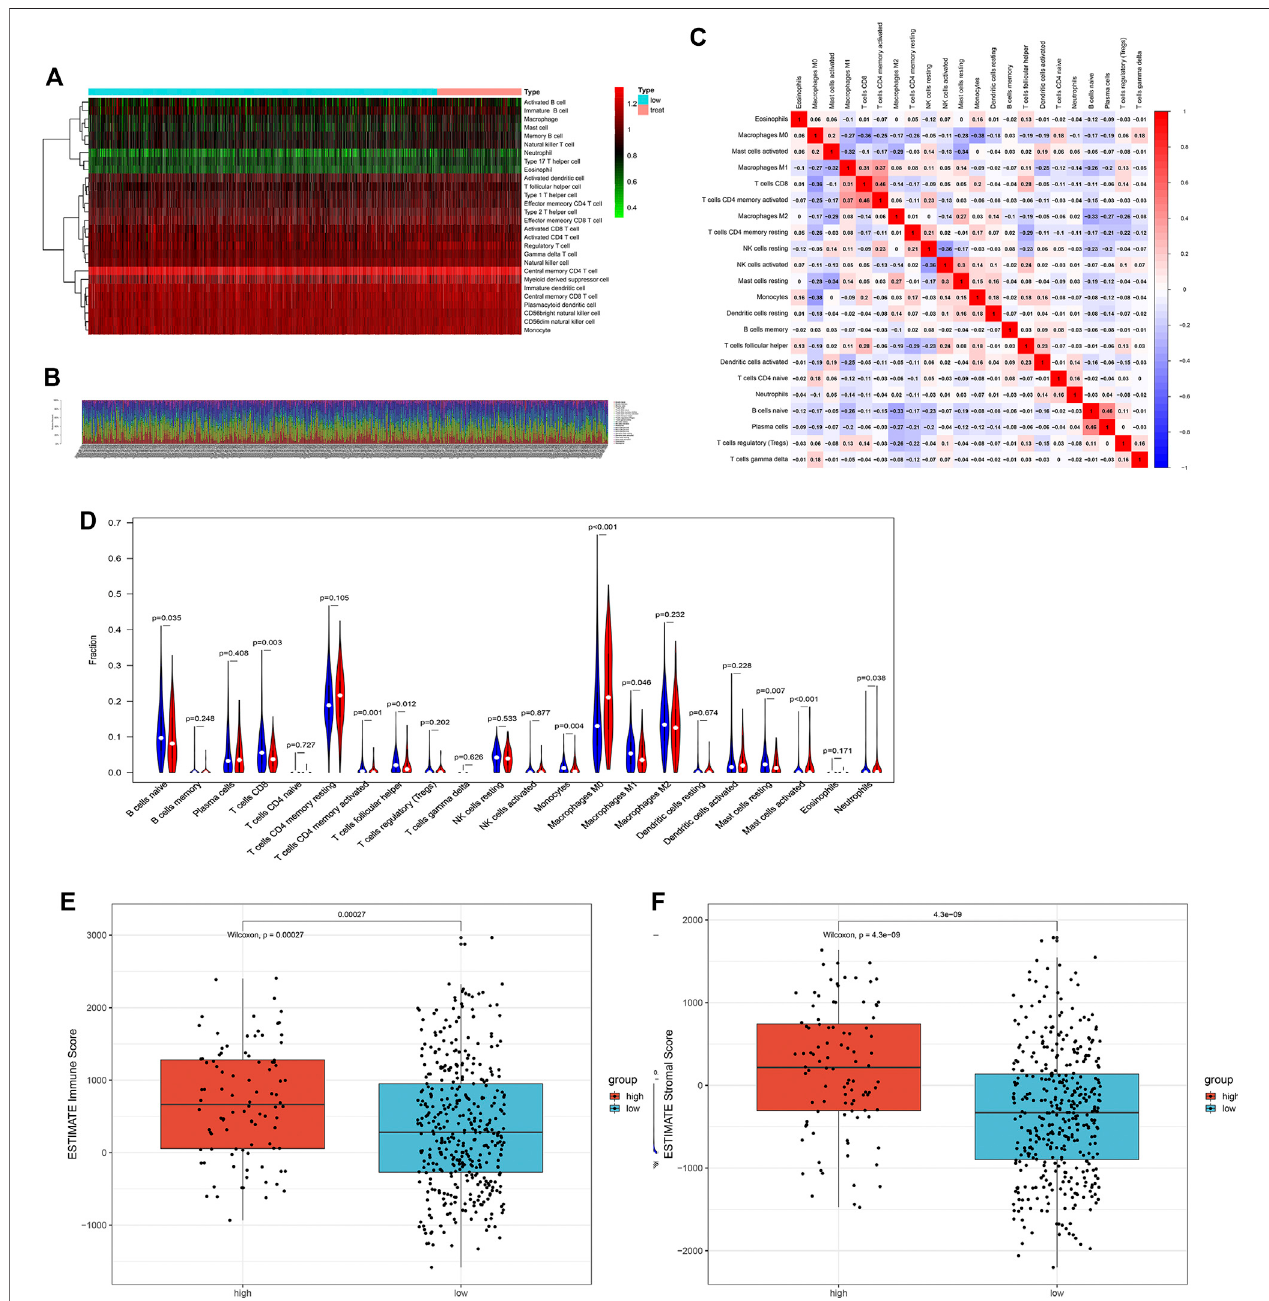
FIGURE6| Thelandscapeofimmunecellin fi ltrationbetweenthehigh-andlow-riskgroupsintheTCGAtrainingcohort. (A) Heatmapofthe28tumor-in fi ltratingcell proportions in ssGSEA. (B) Barplot of22 immune cell in fi ltrationsin CIBERSORT. (C) Correlation matrix ofthe association between the expression level ofthe fi ve ARGs and tumor-in fi ltrating immune cell in fi ltrations. (D) Violin plot showing differences of in fi ltrating immune cell types between the low- and the high-risk groups. (E) Expression of the immune score between the low- and the high-risk groups. (F) Expression of the stromal score between the low- and the high-risk groups.